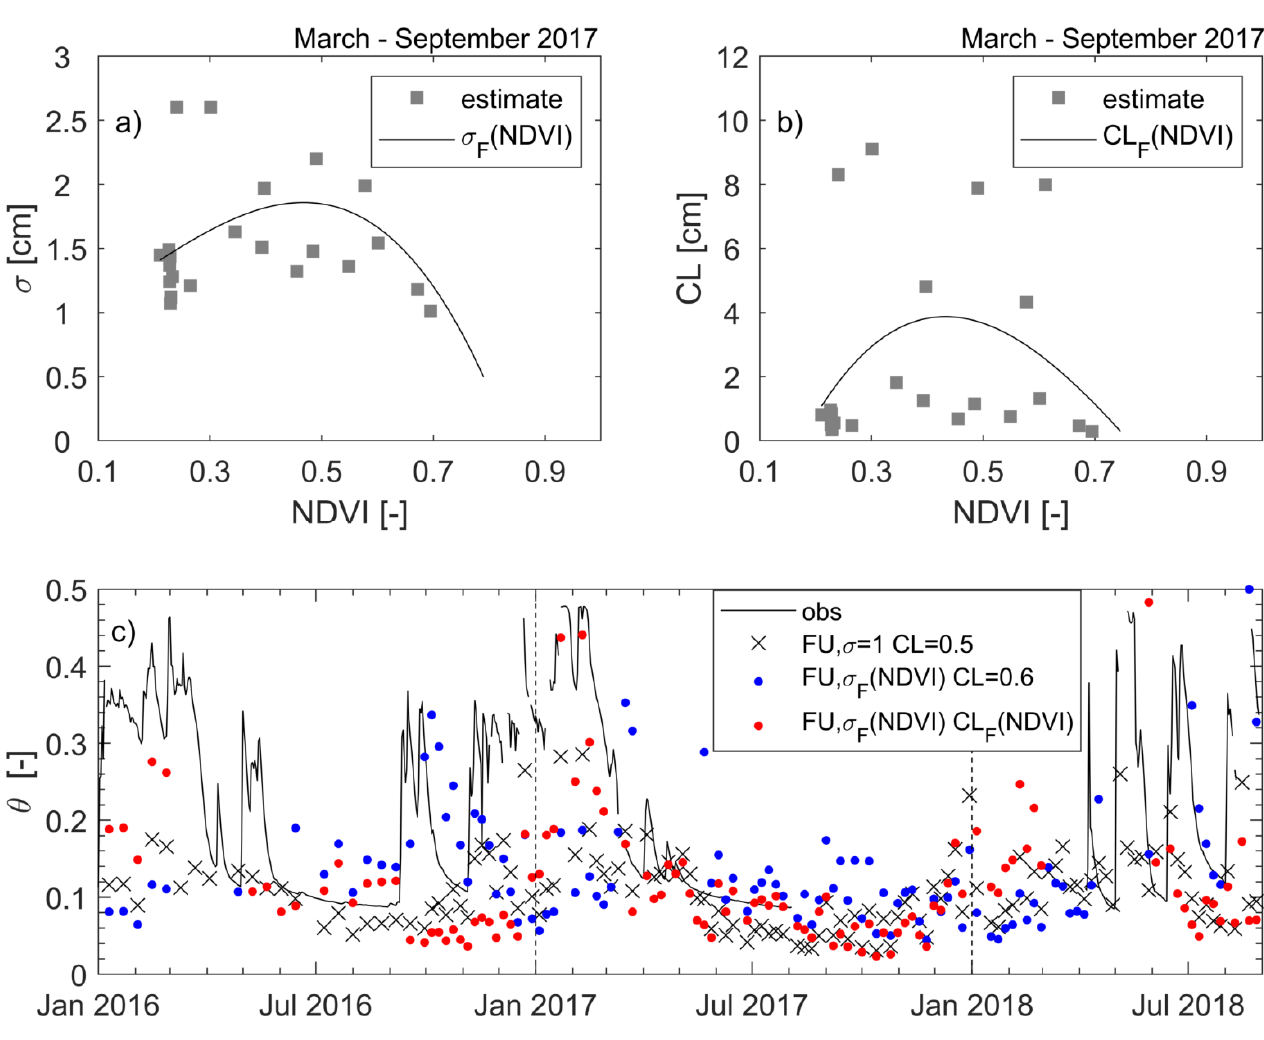
Figure 5. The results using the FU method at the grass field for the 2016–2018 period of: ( a ) estimated roughness length ( σ ) versus corresponding NDVI, and fitted line of equation σ F = − 10.83 NDVI 3 + 5.58 NDVI 2 + 1.88 NDVI + 0.87; ( b ) estimated correlation length ( CL ) versus corresponding NDVI, and fitted line of equation CL F = 37.85 NDVI 3 − 97.48 NDVI 2 + 63.1 NDVI − 8.24; ( c ) comparison of soil moisture observed at the Orroli field site (obs) with soil moisture estimated from Sentinel 1 data using FU and constant σ and CL values (FU, σ = 1, CL = 0.5), using FU and constant CL (= 0.5 cm) and the proposed σ F (NDVI) relationship (FU, σ F (NDVI), CL = 0.5), and using FU and the proposed σ F (NDVI) and CL F (NDVI) relationships (FU, σ F (NDVI), CL F (NDVI)).